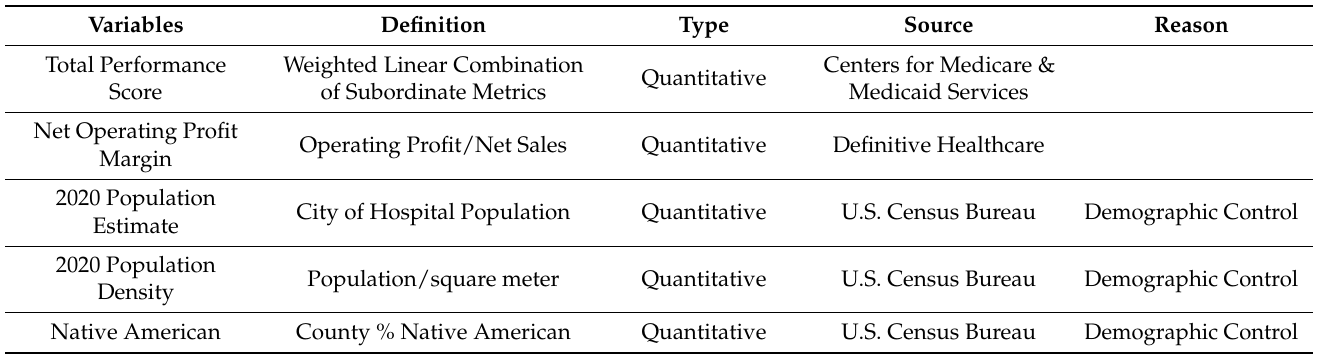
Table 1. Variables in the study and their associated